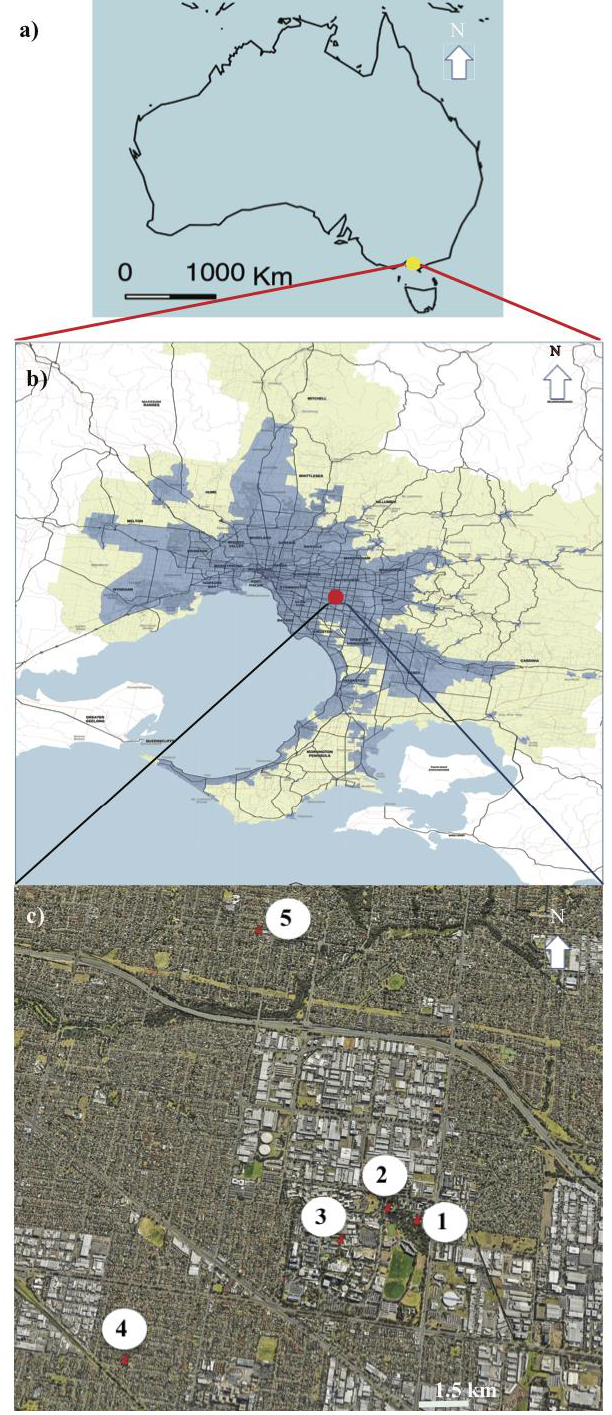
Figure 1. Map of the study area. ( a ) Map of Australia showing the geographical location of the city of Melbourne (solid yellow circle) ( b ) Map showing the urban area of Greater Melbourne (dark blue shaded region) within the urban growth boundary (light green shaded region) and the sampling locations (Source: https://www.sro.vic.gov.au/greater-melbourne-map-and-urban-zones (accessed on 28 May 2019)). ( c ) Aerial view of the study location and sampling sites. The numbers and red marks show the study sites within three different locations (details in sect 2.1 Study area). Sites 1 and 2 have access to remnant native habitat (Jock Marshall Reserve), sites 4 and 5 are residential urban environments; site 3 data collected not considered in main manuscript. Maps a and c were prepared in R v3.5.1 using packages ‘maps’, ‘dismo’, and ‘raster’ [45].